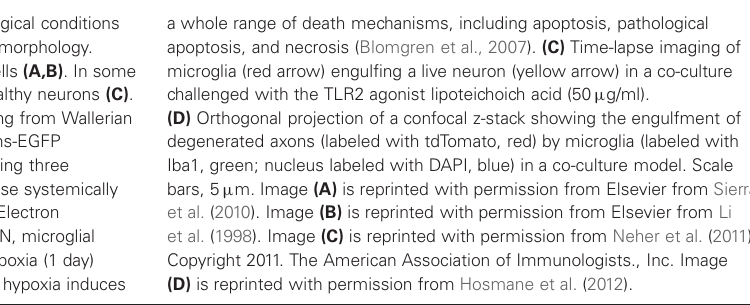
a whole range of death mechanisms, including apoptosis, pathological apoptosis, and necrosis (Blomgren et al., 2007). (C) Time-lapse imaging of microglia (red arrow) engulfing a live neuron (yellow arrow) in a co-culture challenged with the TLR2 agonist lipoteichoich acid (50 μ g/ml). (D) Orthogonal projection of a confocal z-stack showing the engulfment of degenerated axons (labeled with tdTomato, red) by microglia (labeled with Iba1, green; nucleus labeled with DAPI, blue) in a co-culture model. Scale bars, 5 μ m. Image (A) is reprinted with permission from Elsevier from Sierra et al. (2010). Image (B) is reprinted with permission from Elsevier from Li et al. (1998). Image (C) is reprinted with permission from Neher et al. (2011), Copyright 2011. The American Association of Immunologists., Inc. Image (D) is reprinted with permission from Hosmane et al.